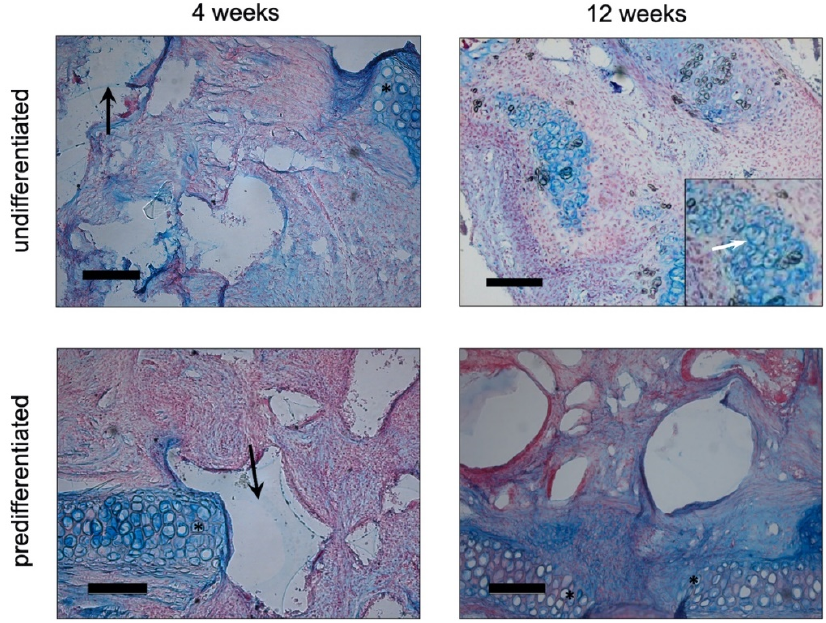
Figure 7. Alcian blue staining of cell-seeded PU-fibrin composites in vivo (New Zealand White Rabbit): In the Alcian Blue images, the native auricular cartilage in the region of the defect margin is visible (*). The PU-fibrin construct was slightly thicker than the native cartilage of the auricle, and thus it protruded above the level of the cartilage. Polygonally shaped sections of the PU foam can be seen in the images of the constructs explanted after 4 weeks (black arrows). After 4 weeks, an even distribution of cells and blue-turquoise stained areas could be found within the pores of the PU foam. After 3 months, there were structures with more pronounced blue colouration inside the pores of the construct similar to cartilage lacunae in both groups. The insert shows a clearly accentuated blue staining around these “lacunae” at a higher magnification + highlighted by a white arrow. Qualitatively, no remarkable difference between the groups could be detected. Magnification is × 100 in all figures; the scale bar represents 200 μ m.